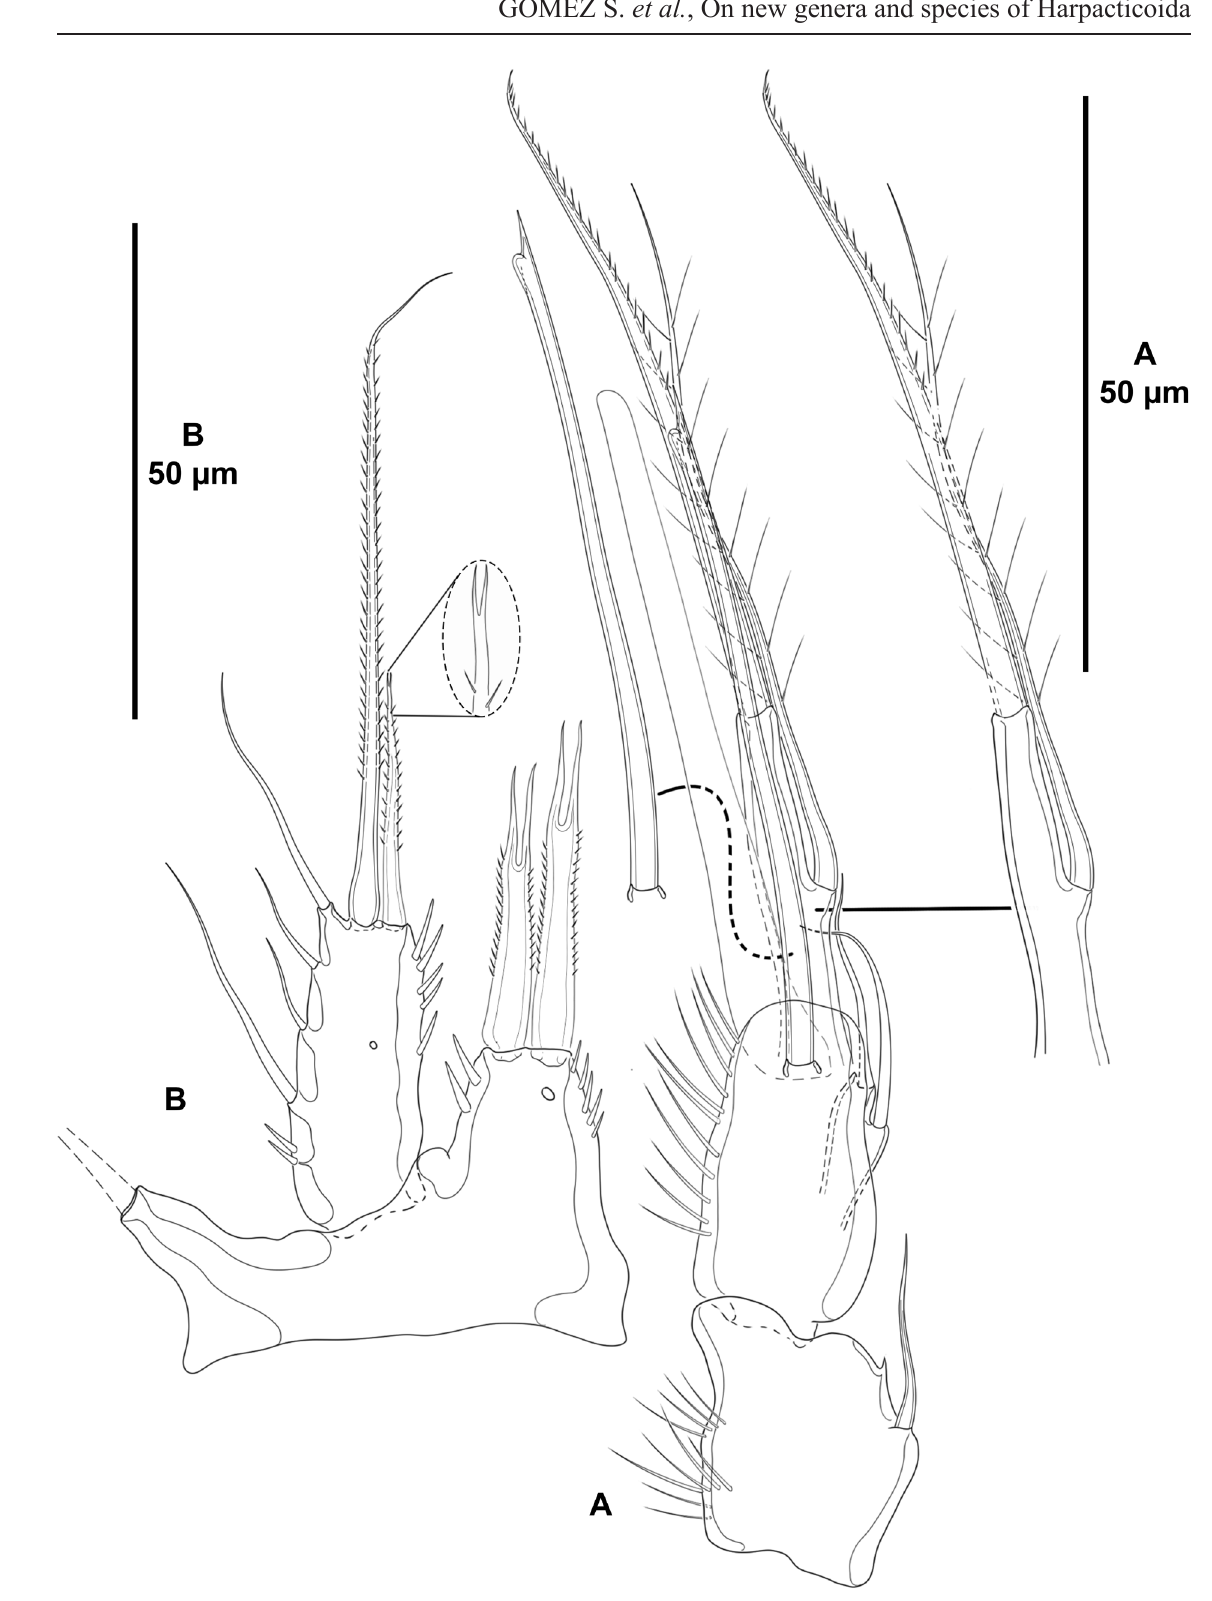
Fig. 10. Typhlamphiascus medici sp. nov., paratype, ♂ (ICML-EMUCOP-180119-44). A . P2 ENP. B . P5, anterior